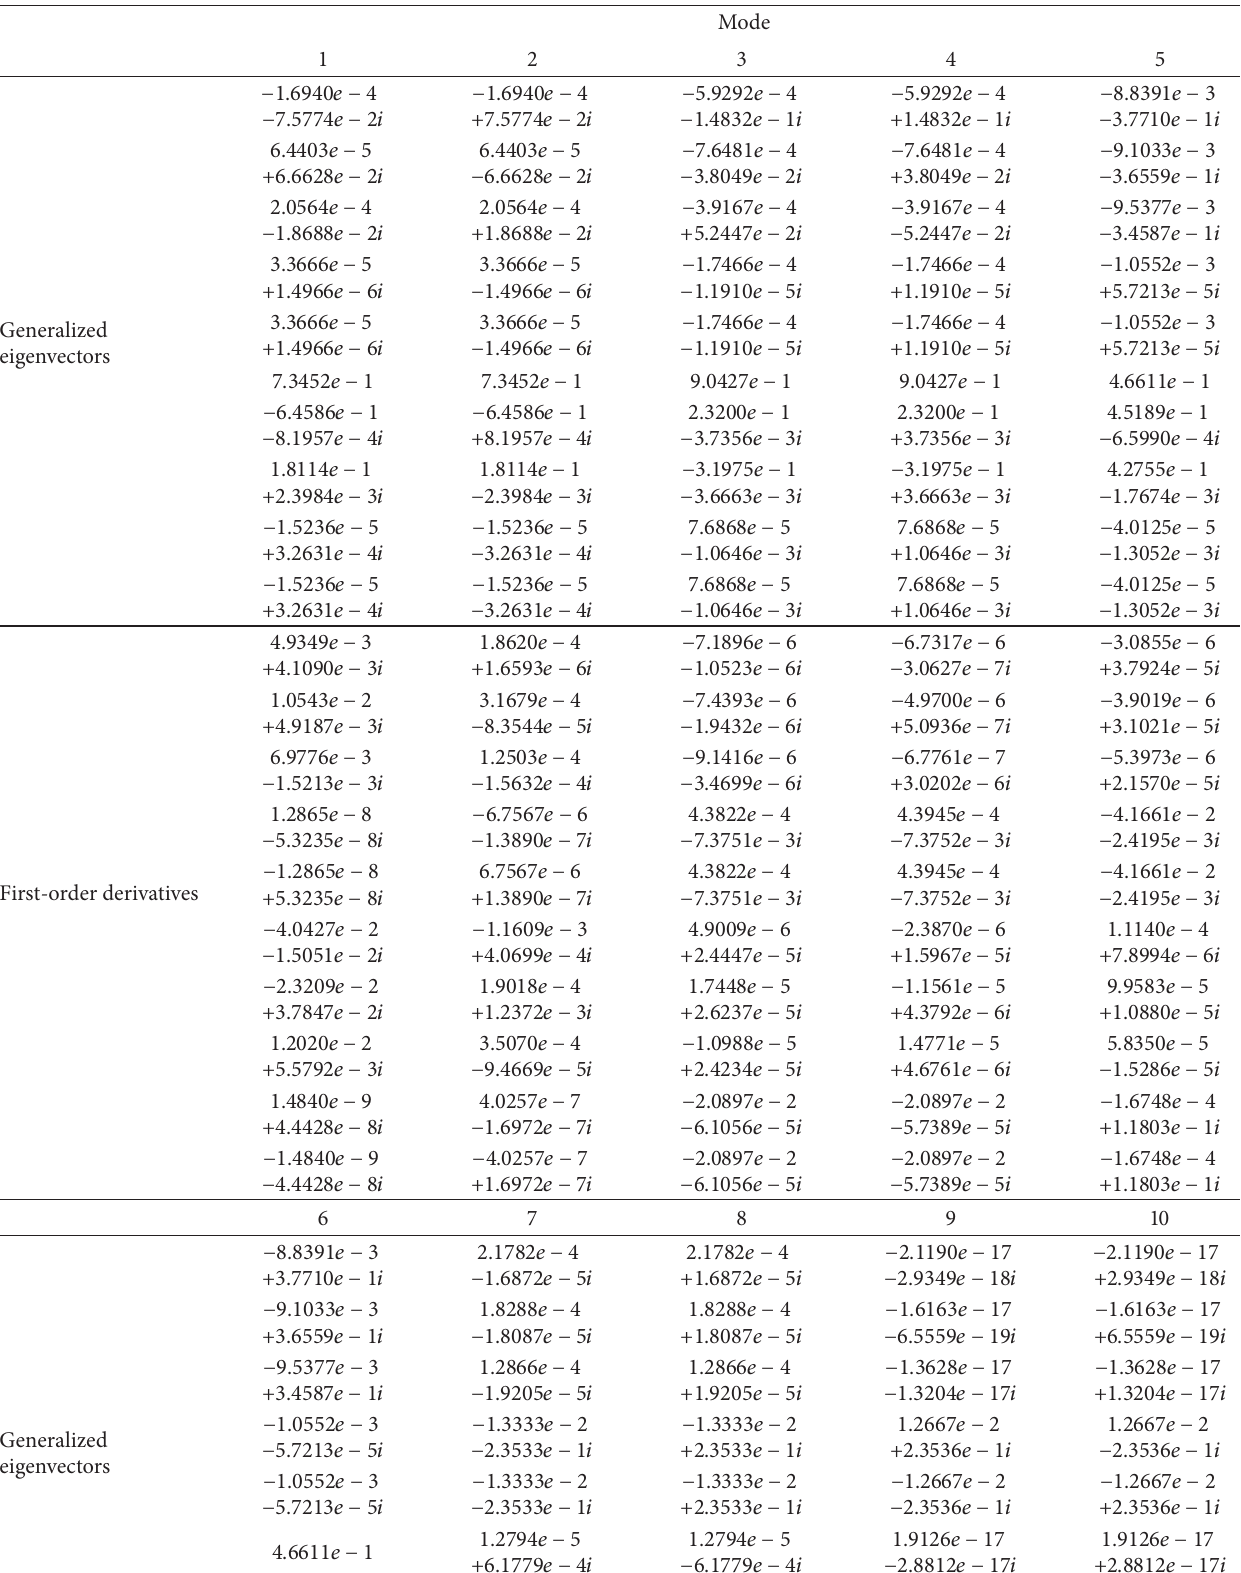
Table 1: Result of eigenvectors and the sensitivity